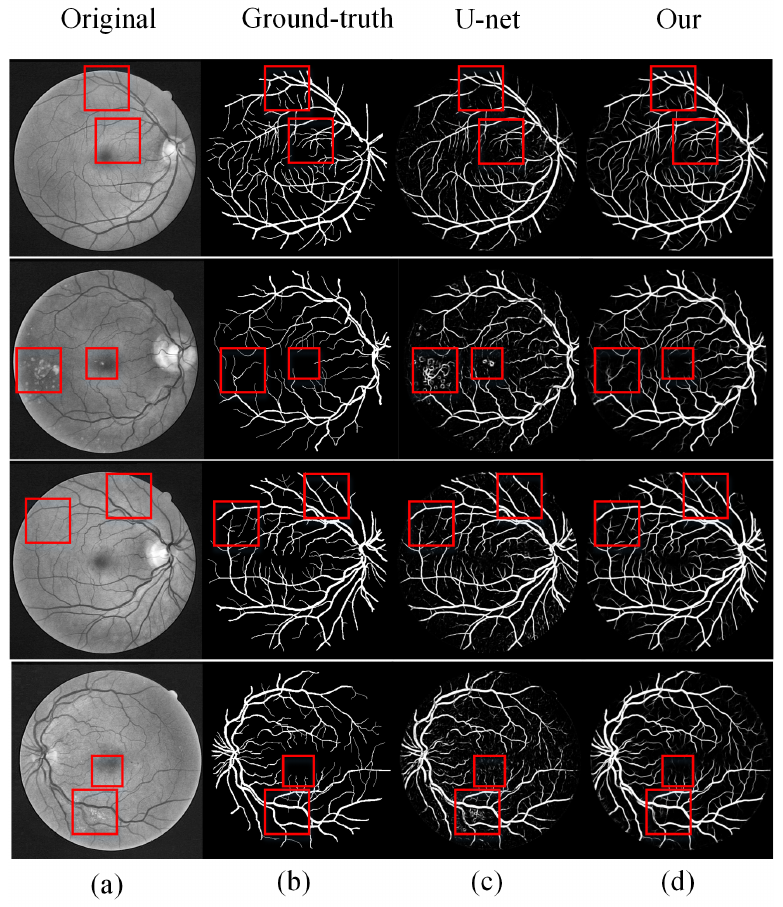
Figure 10. Comparison of DRIVE segmentation results: ( a ) original image, ( b ) ground-truth, ( c ) U-Net segmentation results, and ( d ) MRU-Net segmentation